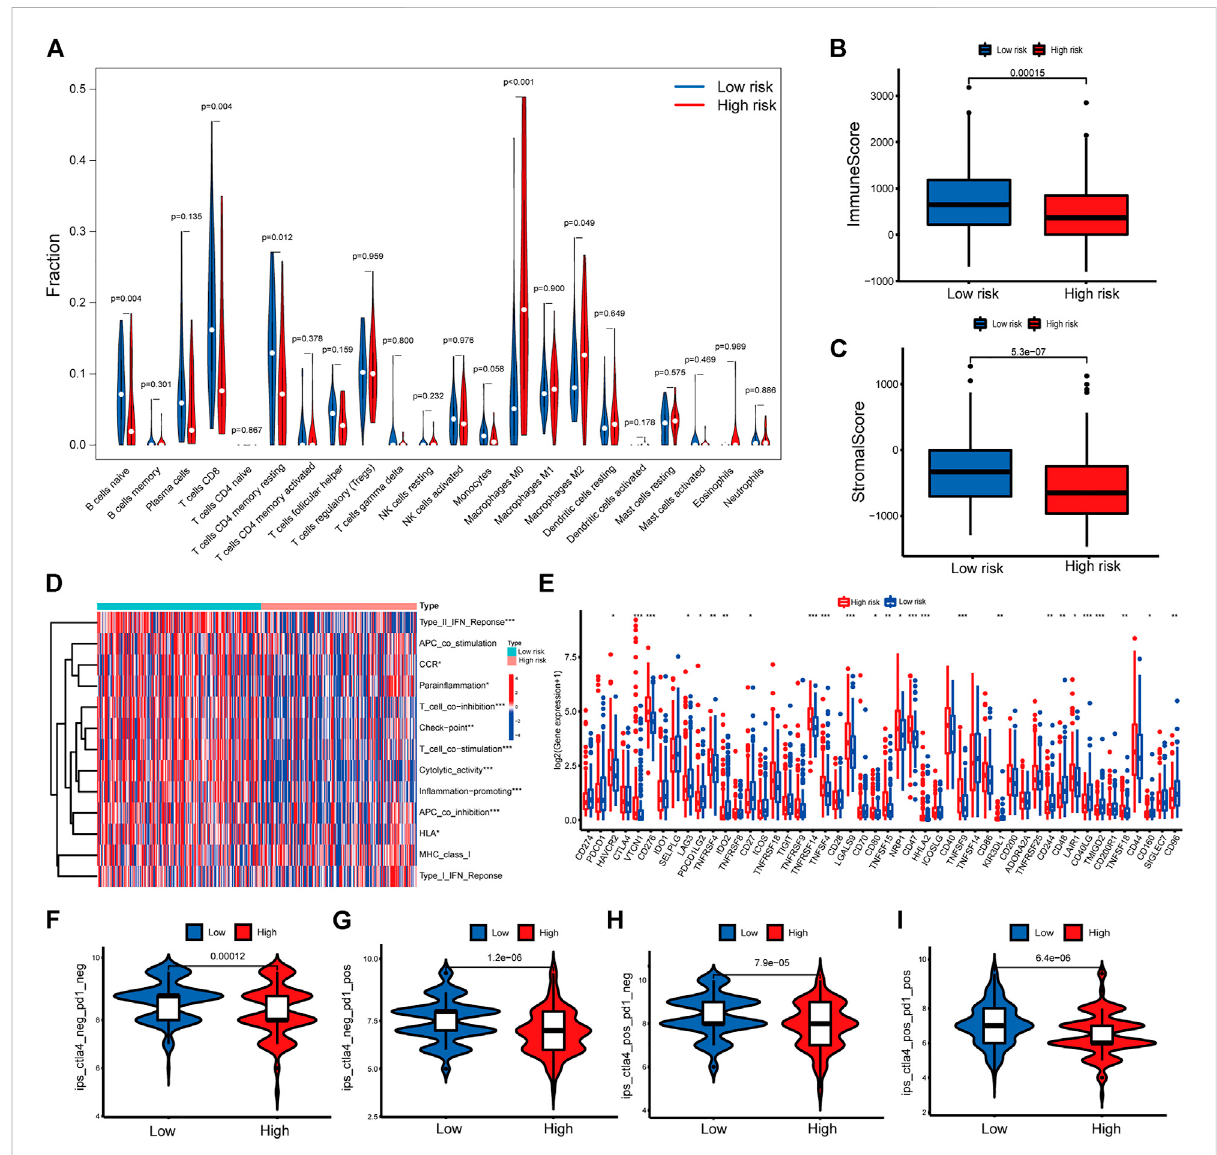
FIGURE 6 Immune related analysis in high- and low-risk groups (A) Differences in the in fi ltration of immune cells between the high- and low-risk groups. (B – C) Comparisonofimmunescore (B) ,andstromalscore (C) betweenthehigh-andlow-riskgroups (D) Thecorrelationbetweenthesignatureand 13 immune-related functions. (E) Differential expression of immune checkpoint genes between the high- and low-risk groups (F – I) IPS values of patients categorized according to risk score of four subtypes [IPS-CTLA4-neg-PD1-neg (F) , IPS-CTLA4-neg-PD1-pos (G) ,